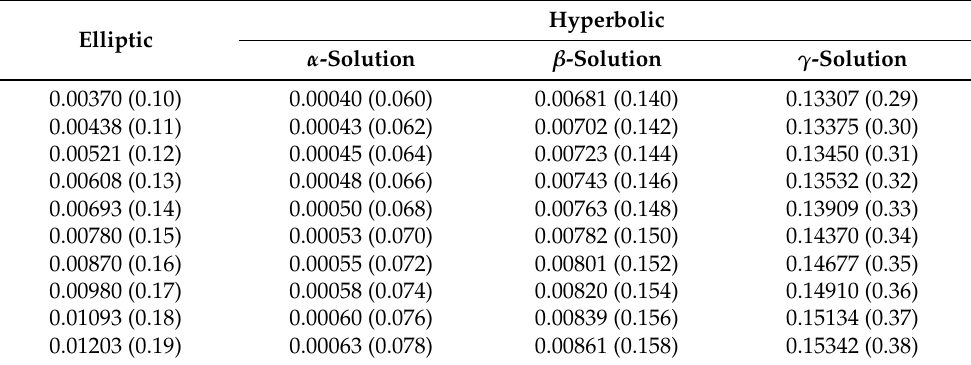
√ Table 1. The MSE of local regression method with l = 1 and bandwidth h (presented in parenthesis) in estimating the critical collapse response function g ( z ) = b 2 based on a training sample of size n = 100.